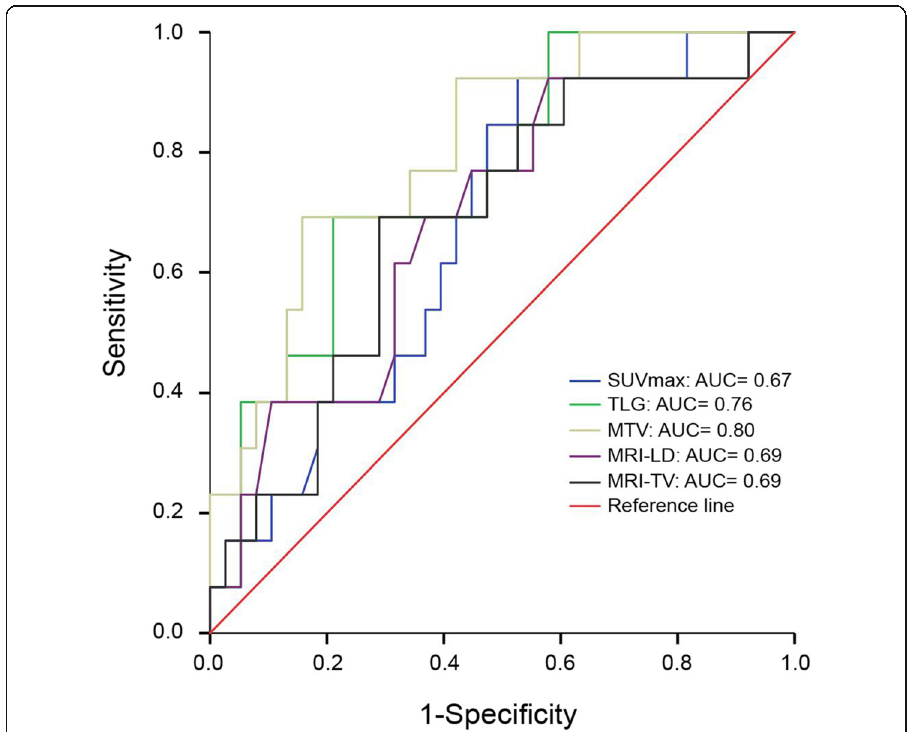
Fig. 3 Receiver operating characteristic curve analyses of MTV, TLG, MRI-LD and MRI-TV values for predicting progression and